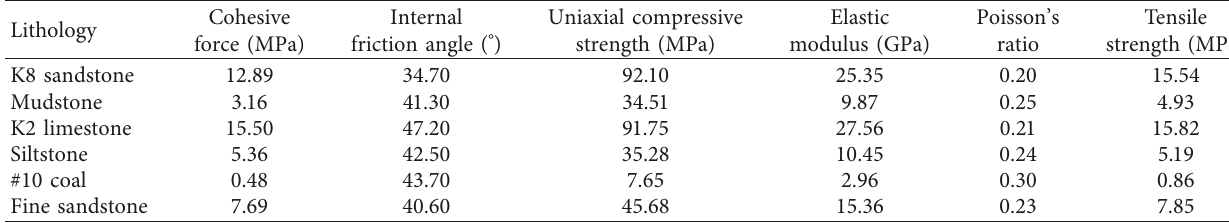
Table 1: Mechanical properties of coal and rock.